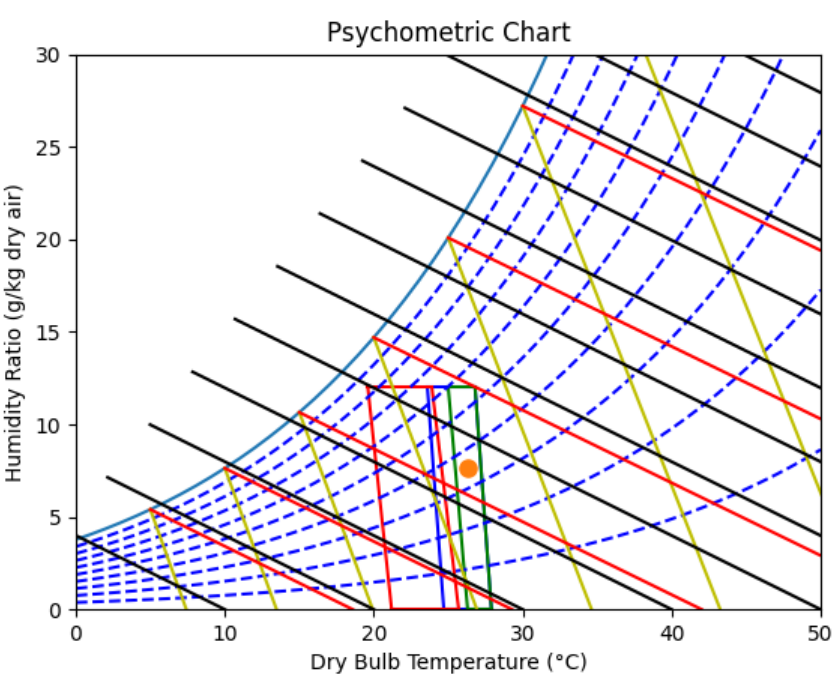
Figure 16. Psychometric chart software output.